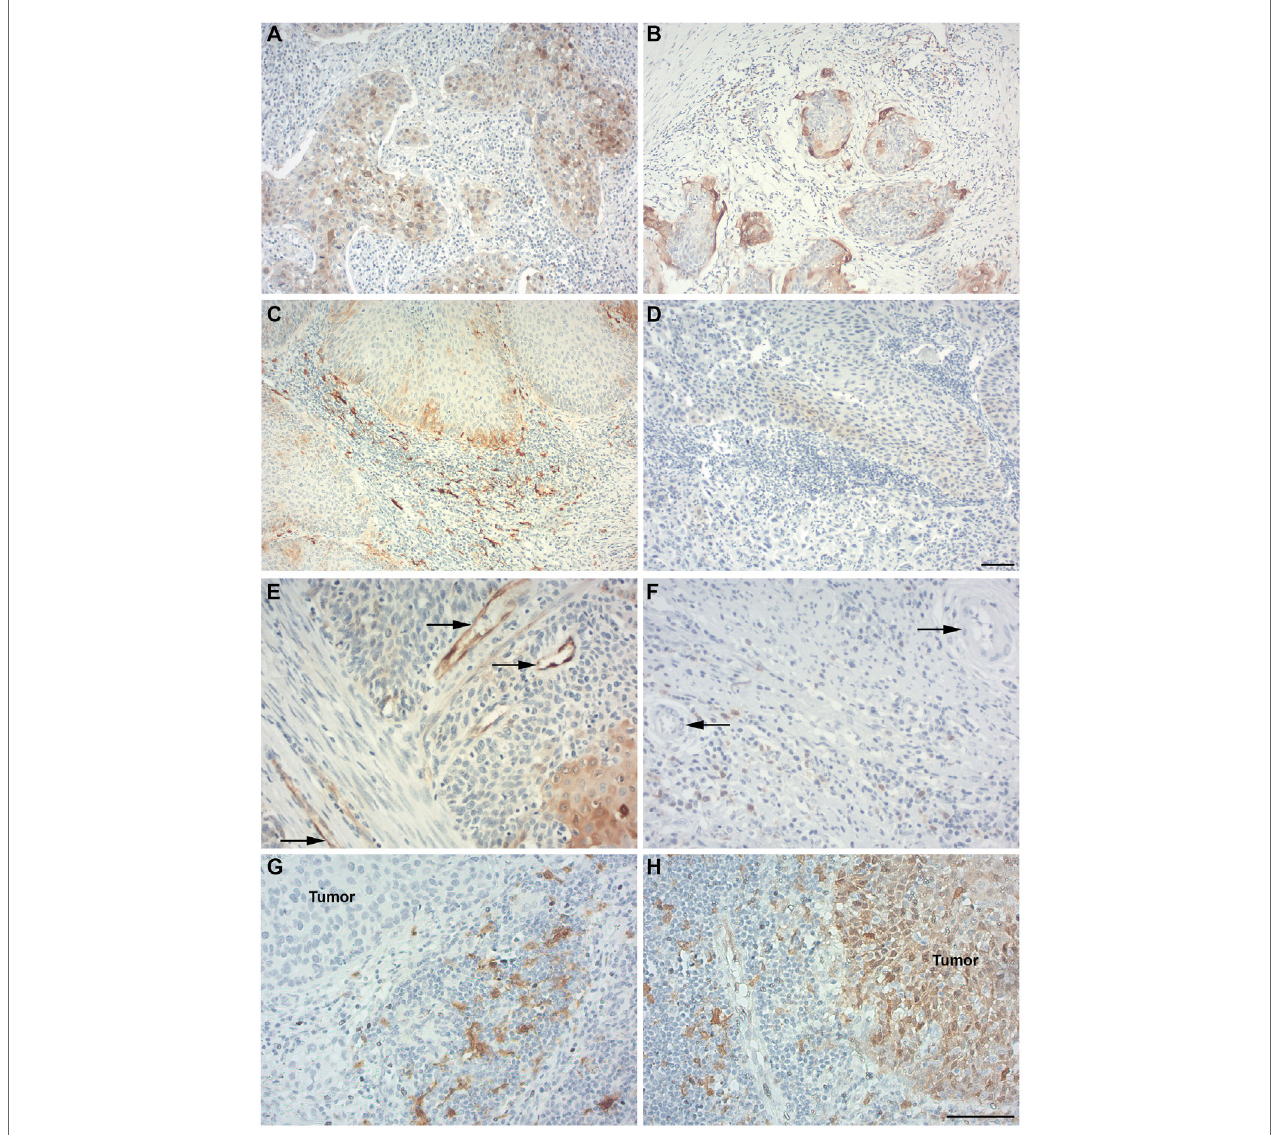
FigUre 1 | Indoleamine 2,3-dioxygenase (IDO) expression in primary cervical cancer and metastatic lymph nodes. Different patterns for IDO expression (in brown) were detected in primary- and metastatic cervical squamous cell carcinoma. (a) Patchy pattern with cytoplasmic IDO expression by primary tumor (PT) cells. (b) Marginal IDO expression by PT cells. (c) High numbers of IDO-expressing stromal immune cells in a marginal IDO-expressing tumor. (D) IDO-negative tumors, with low IDO expression in PT cells and stromal immune cells. (e) IDO-positive tumor-associated vessels (indicated by black arrows). (F) IDO-negative tumor-associated vessels (indicated by black arrows). (g) Metastatic lymph node sample showing metastatic tumor cells negative for IDO and IDO-positive immune cells surrounding the tumor fields. (h) Metastatic lymph node sample showing nuclear and cytoplasmic IDO expression by metastatic tumor cells and IDO-positive immune cells. Magnification for (a–D) is 100 × [scale bar in (D) is 100 µm] and for (e–h) [scale bar in (h) is 100 µm] is 200 ×